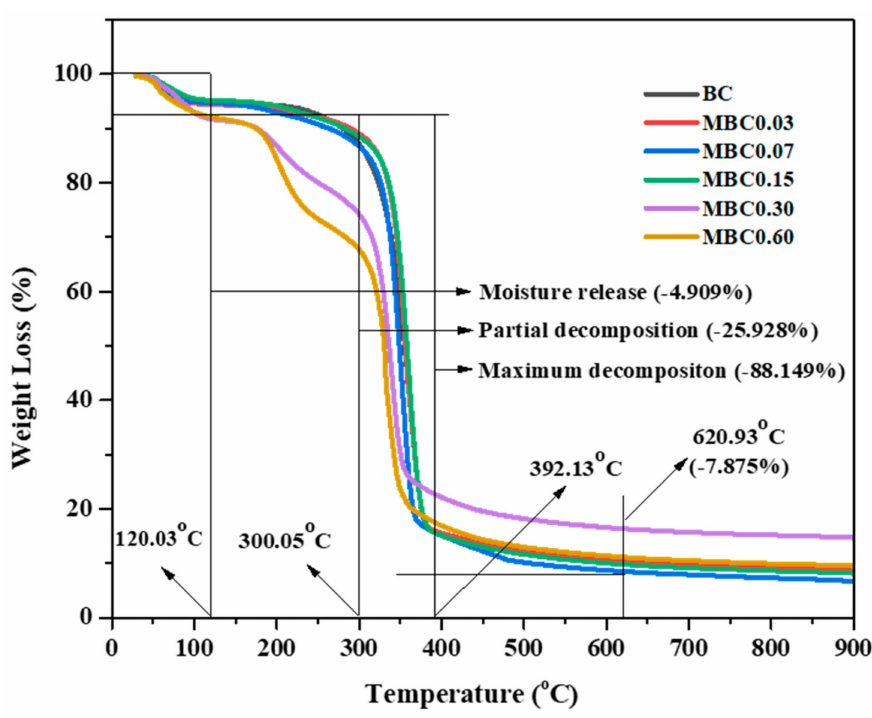
Figure 7. Thermal gravimetric analysis (TGA) graphs of the unmodified and modified BC samples.